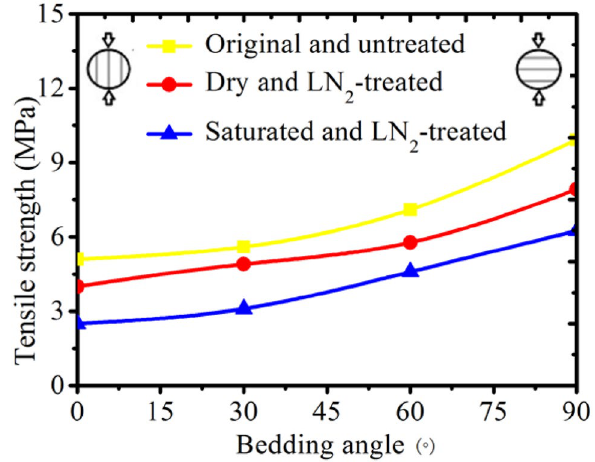
Fig. 4 Permeability of different bedding shales before and after LN cooling